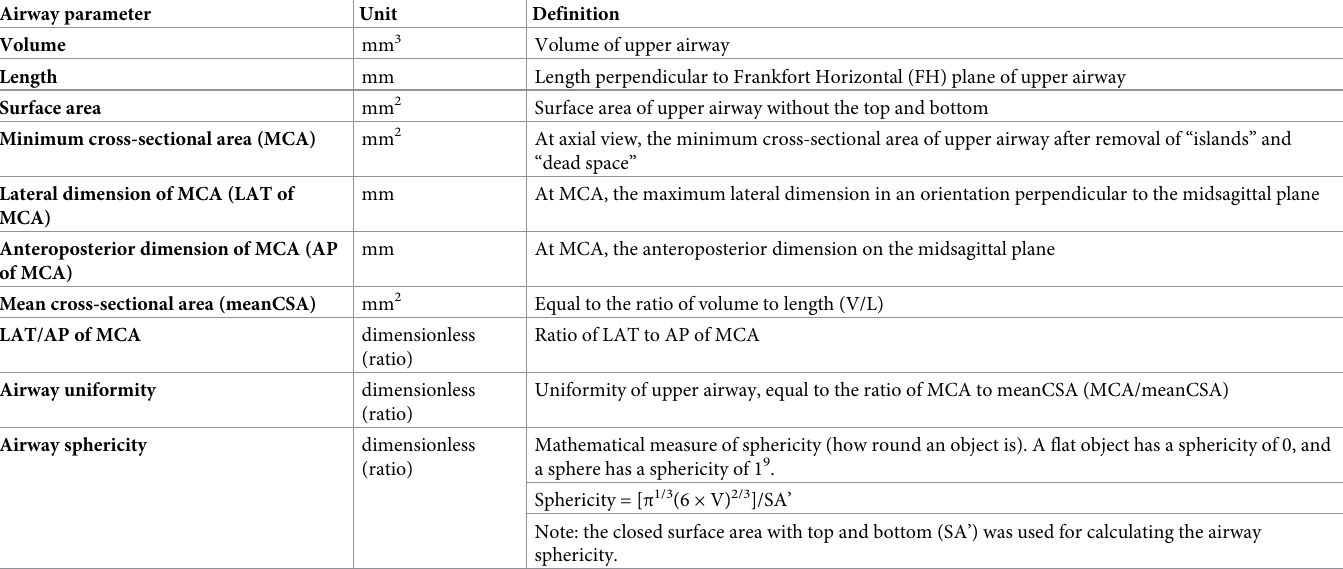
Table 1. Definition of airway